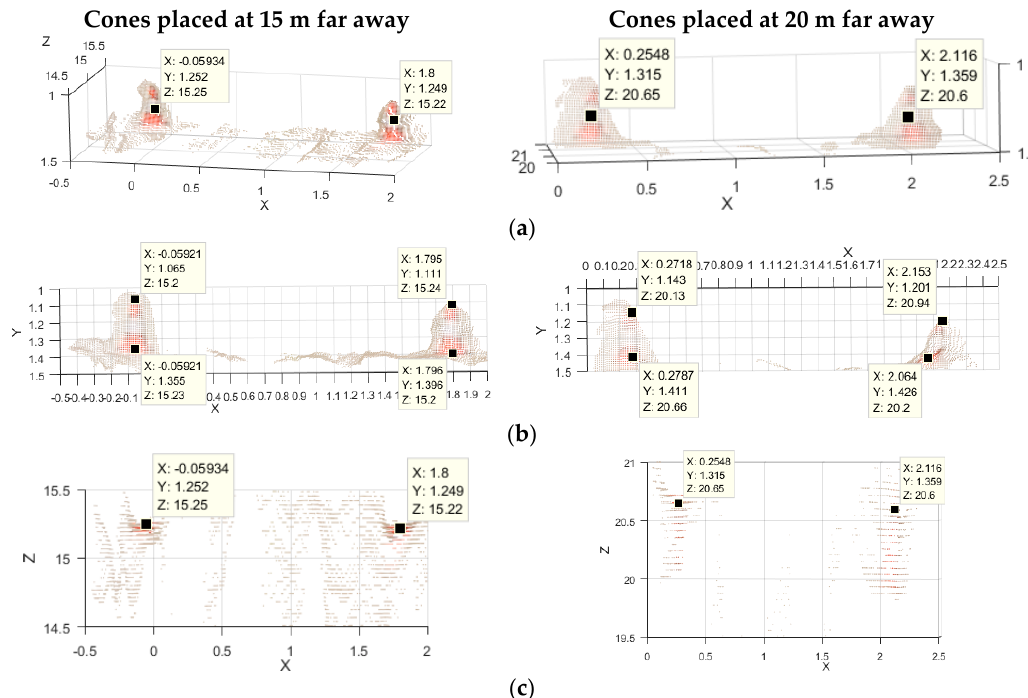
Figure 6. Analysis of small narrow objects in the farthest half of the Range Field (long-range camera sensor). 3D control points were located at similar places for each couple of cones for the analysis. ( a ) Detail of the 3D representation of the targets; ( b ) Frontal view of the targets (grid sized 10 cm); ( c ) Top view of the 3D point clouds (grid sized 50 cm). For the cones at 20 m the fattening effect becomes evident (depth artifact).